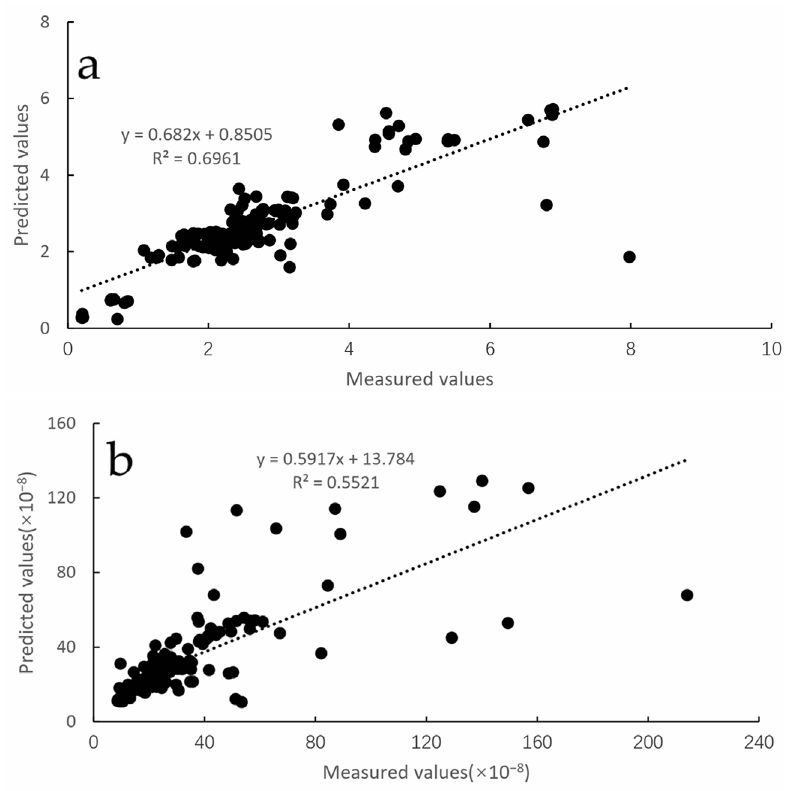
Figure 5. Correlation between predicted and measured values. ( a ) fish density; ( b ) acoustic biomass.